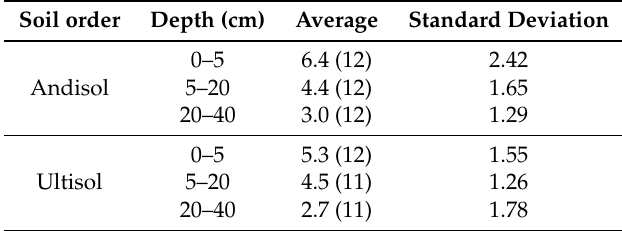
Table 1. Average of soil total carbon (TC) of each depth sampled for the two soil orders (Andisol and Ultisol). In brackets the numbers of samples